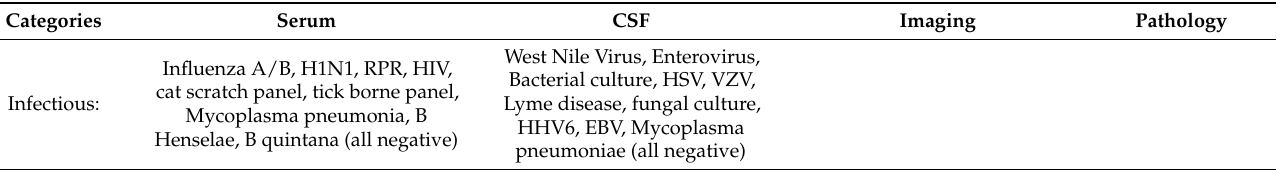
Table 1. Summary work-up for New-Onset Refractory Status Epilepticus (NORSE)